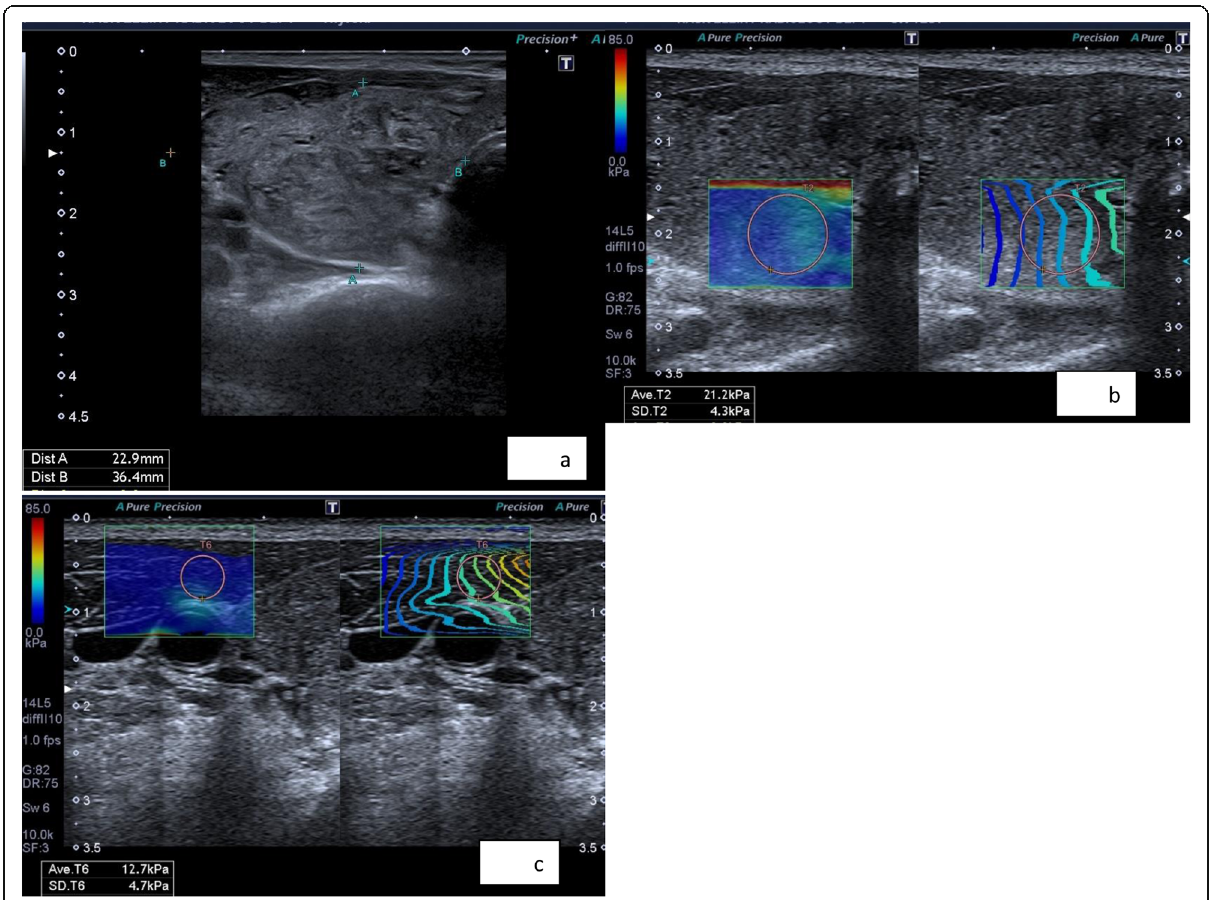
Fig. 4 Ultrasound images for a 55-year-old male patient. a Axial ultrasound B-mode image is showing a right solid heterogeneous thyroid nodule (TI-RADS 3). b Axial SWE of the thyroid nodule ( E mean = 21.2 kPa and ER = 1.6). c Axial SWE of the normal right sternocleidomastoid muscle; the FNAC revealed abundant lymphocytic cells with scanty follicular cells (Bethesda 2), and the post total thyroidectomy histopathological results had confirmed the diagnosis of chronic lymphocytic thyroiditis; thus, SWE EIs were matching the cytological